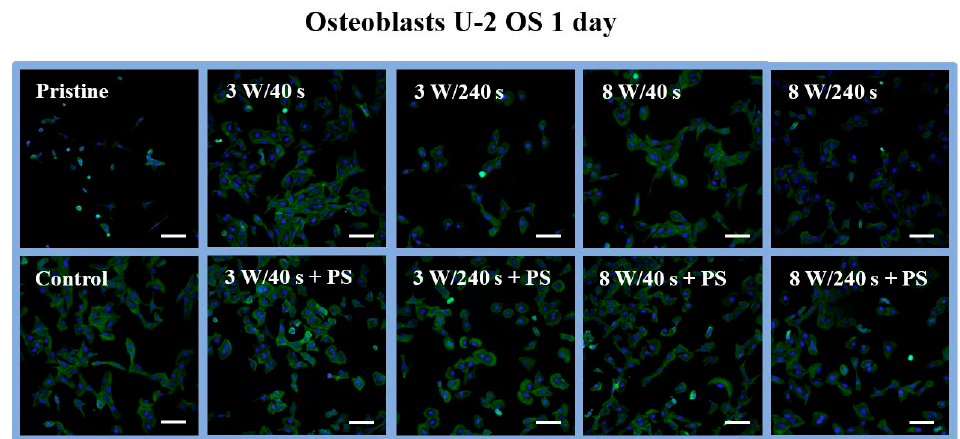
Figure 9. Fluorescence microscopy images of human osteoblasts (U-2 OS) at 1 day post-seeding on FEP (pristine), FEP matrices treated using plasma with 3 and 8 W (40 and 240 s) and subsequently coated with a honeycomb-like pattern formed from PS. As a control, glass coverslips were used. Nuclei stained with DAPI are in blue, F-actin labeled with phalloidin-Atto 488 is in green. The scale bars represent 100 µm.